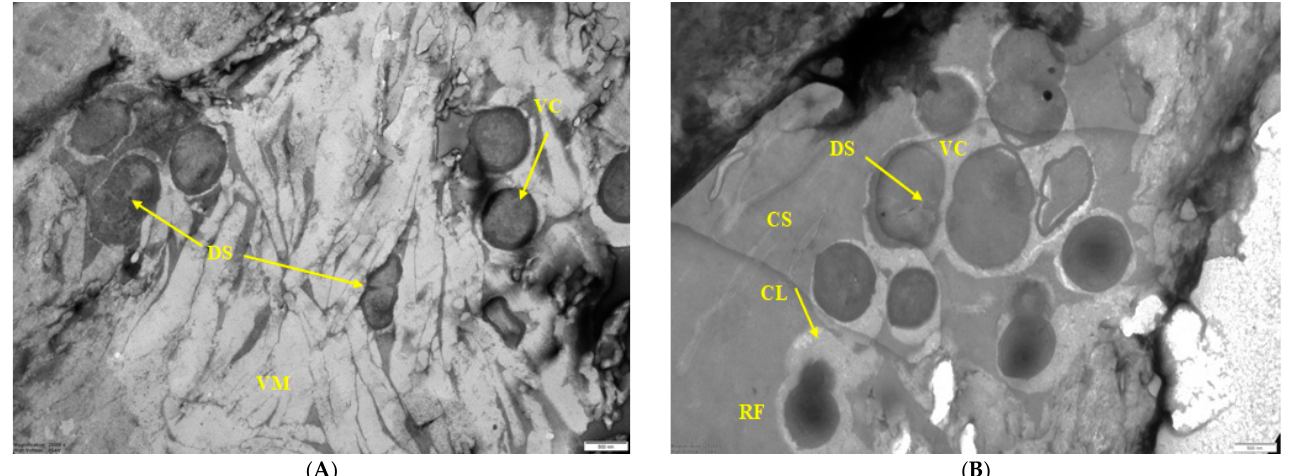
Figure 6. Electron micrographs of sample 5. ( A )—zone of BF with veiny material; ( B )—zone rich of cells in carbohydrate matrix. Designations: M—matrix (veiny structures VM or carbohydrate structures CS); VC—vegetative cells, and RF—resting forms of the same microcolony; DS—division septum; CL—capsular layer. Scale bar is 0.5 µm.